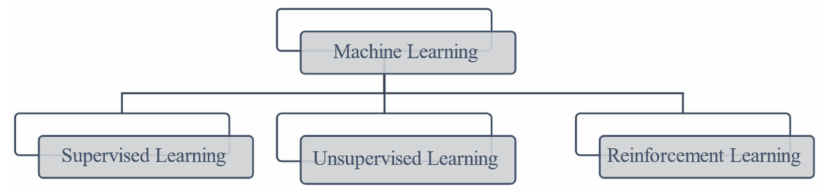
Figure 1. Machine Learning paradigms.